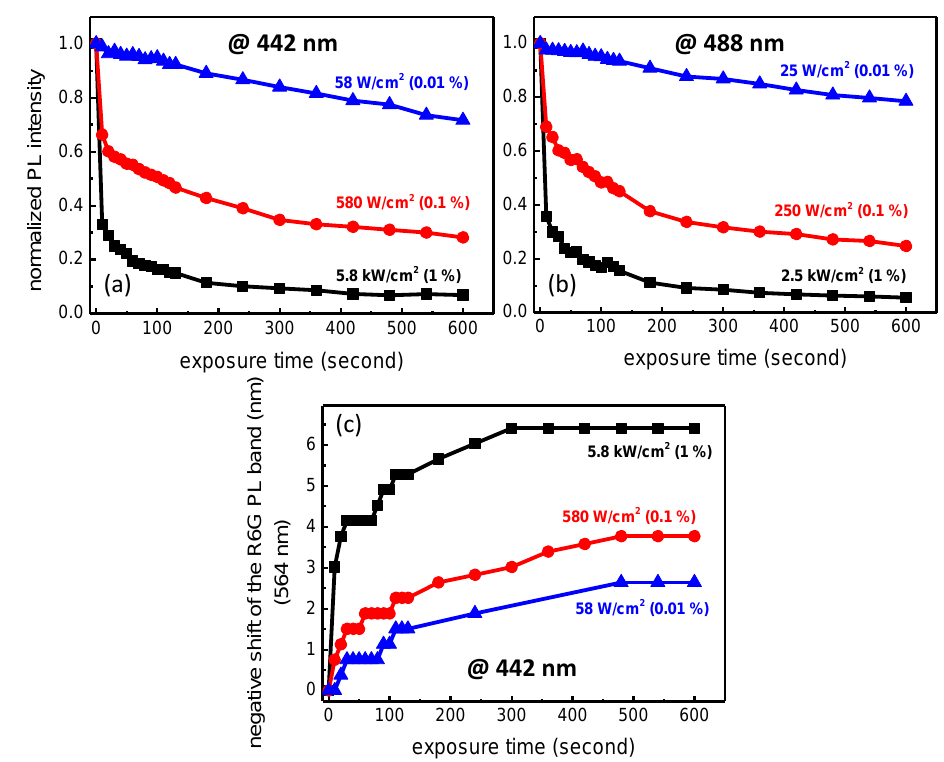
Figure 5. Degradation of the R6G luminescence under excitation at 442 nm with power densities of 5.8 kW/cm 2 , 580 W/cm 2 and 58 W/cm 2 ( a ). Degradation of the PL under excitation at 488 nm (2.5 kW/cm 2 , 250 W/cm 2 and 25 W/cm 2 ( b ). Negative shift of the PL band under excitation at 442 nm ( c ).